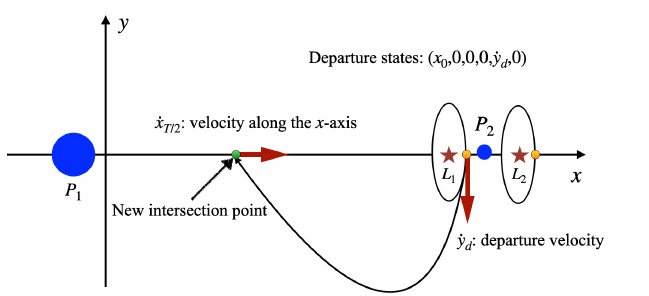
Figure 12. Schematic diagram of generation of the initials of RTPOs in the Sun–Jupiter system.